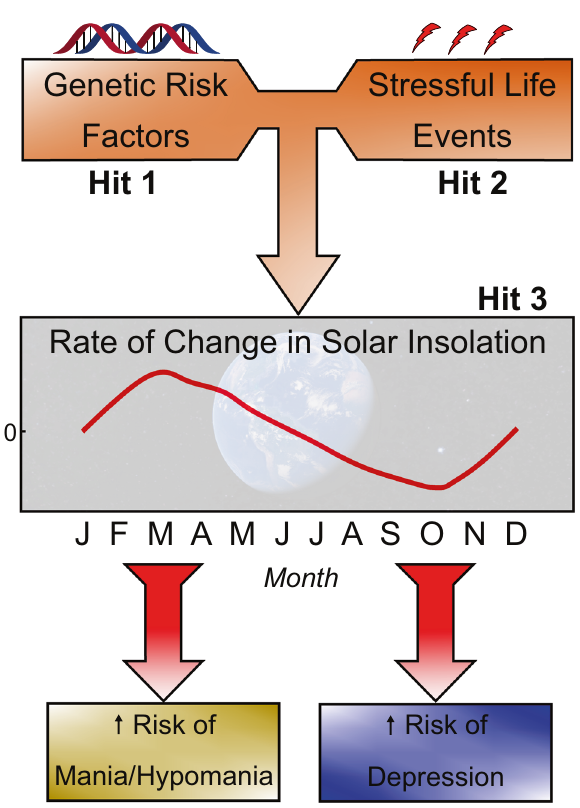
Fig. 1 A 3-hit model of BD involving an interaction of risk genes (Hit 1) and life stressors (Hit 2) that is fi ltered through seasonal changes in photoperiod (Hit 3), represented as rates of change in solar insolation. An idealized pattern of rates of seasonal changes